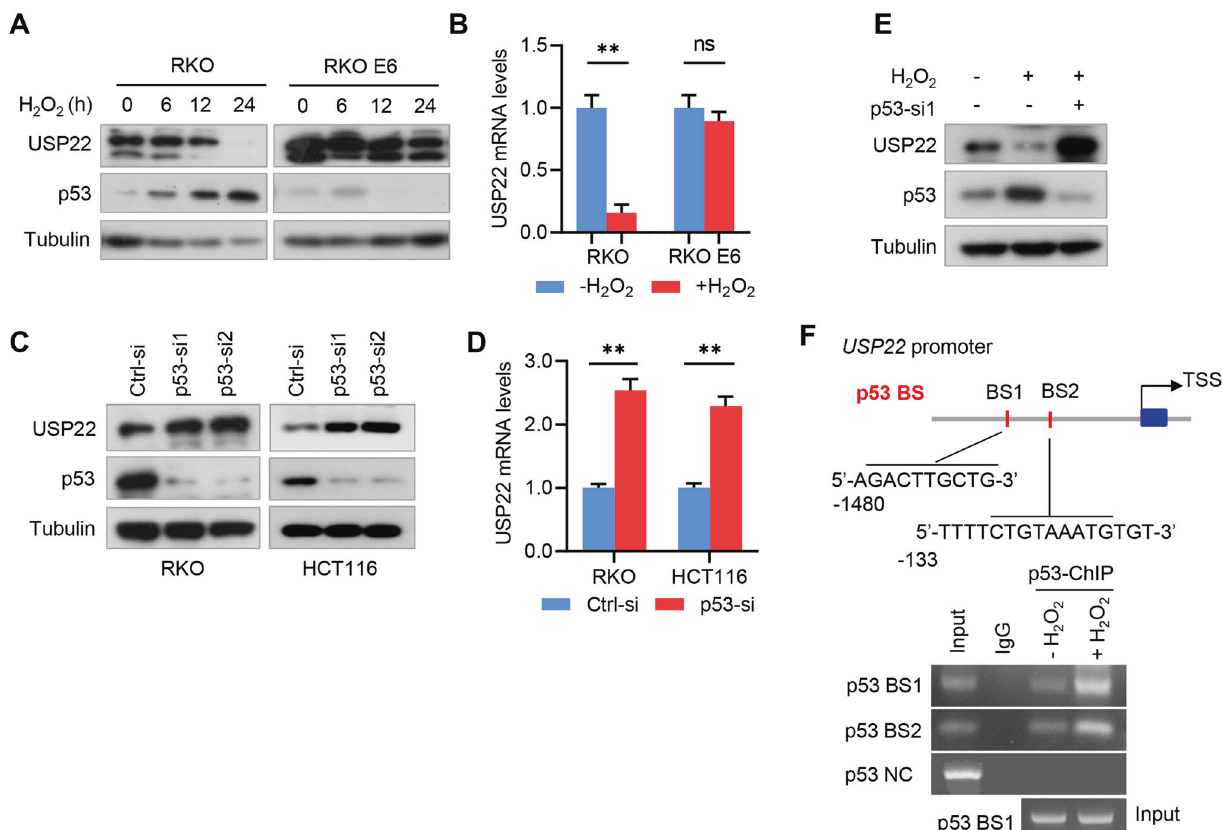
BODIPY 493/503 staining Cellular lipid droplets were stained with Bodipy 493/503